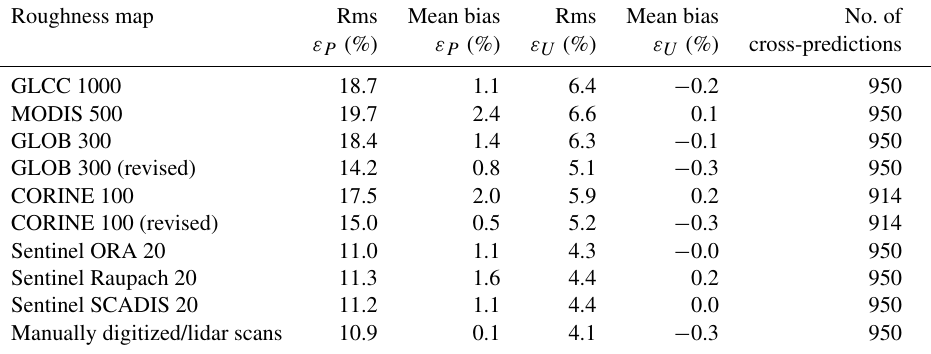
Table 4. RMSE in power density ( ε P , %) and wind speed ( ε U , %) for all sites combined. For GLOB 300 and CORINE 100 both the original and revised land cover databases are shown (see Sect. 3.2 and Appendix A, Tables A4 and A3). Roughness